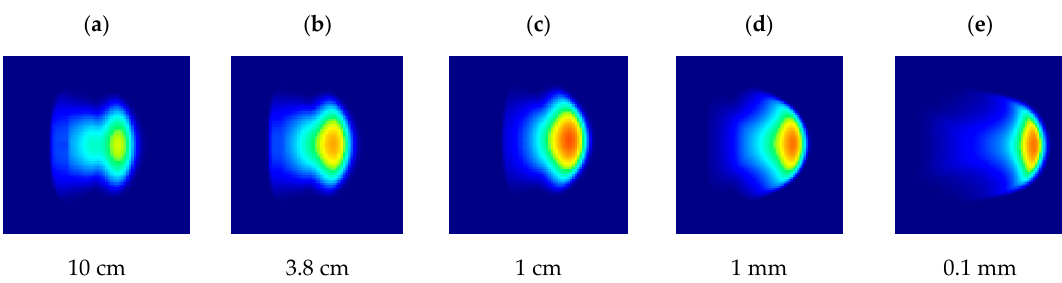
Figure 8. The final deposit shape of simulated flows for δ 2 = 29° and δ s = 20° (case 05). The particle diameters are ( a ) d = 10 cm, ( b ) d = 3.8 cm, ( c ) d = 1 cm, ( d ) d = 1 mm, and ( e ) d = 0.1 mm. Despite the similar qualitative features, the simulated velocities show a large difference from the experimental profiles with 𝛿 (cid:2870) = 29°. This discrepancy becomes smaller when both 𝛿 (cid:2870) and 𝛿 (cid:3046) are increased. As the simulated flow of smaller particles is faster than that of larger particles, the larger the particles become, the better the velocity fits with the experimental results. resemble the experimental results in the case of δ 2 = 32° and δ 2 = 33° (Figure 10). The maximum velocity of the experimental results is especially similar to that in the simulated cases of { δ s = 26°, δ 2 = 32°} and { δ s = 20°, δ 2 = 33°}.